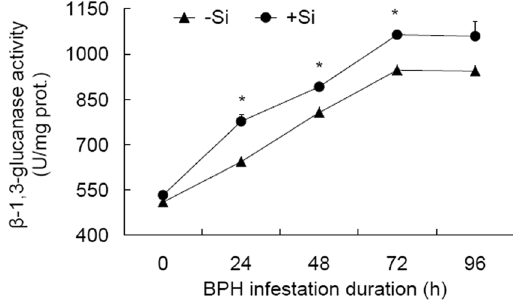
Figure 4. Activitiy of β -1,3-glucanase in rice sheaths in response to Si amendment and BPH infestation. + Si = silicon amendment to rice plants at 112 mg Si/kg nutrient solution, − Si = no silicon amendment. Error bars represent 1 × SE. n = 3 (biological replicates). * Significant difference between + Si and − Si plants at a certain time post BPH infestation at P < 0.05 via independent samples T